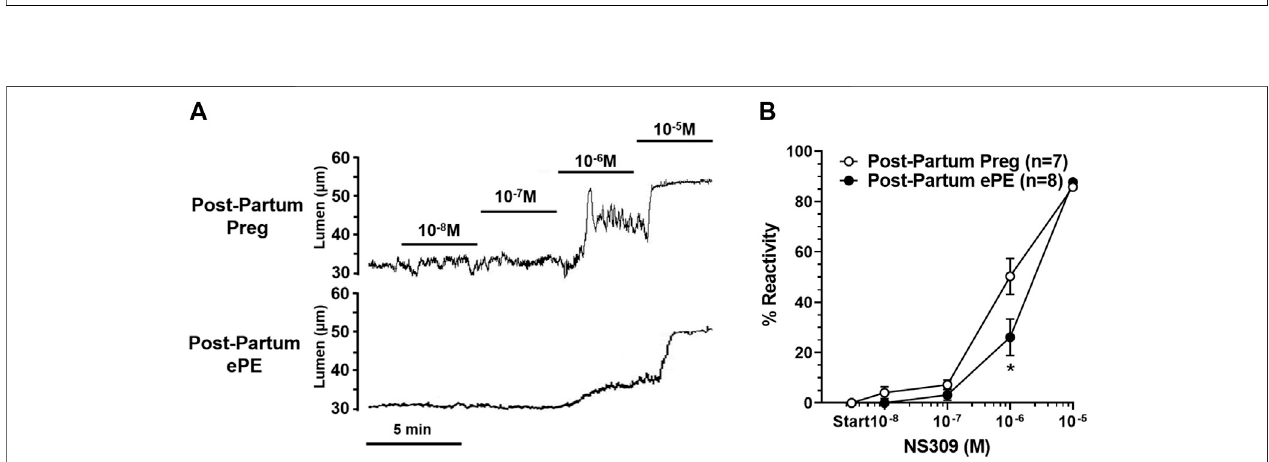
FIGURE2| Activelumendiametersandmyogenictoneofhippocampalarterioles(HAs). (A) PhotomicrographofapressurizedHAinanarteriographchamberwith 40% myogenic tone. Boxed inset denotes the section of arteriole where lumen diameters and wall thickness measurements were made. Scale bar is 50 µm. (B) Lumen diameters of HAs from Post-Partum Preg and Post-Partum ePE rats were similar across the intravascular pressure range of 20 – 120 mmHg. (C) Calculated percent myogenic tone was similar between groups at all pressures investigated. Data are mean ± SEM.